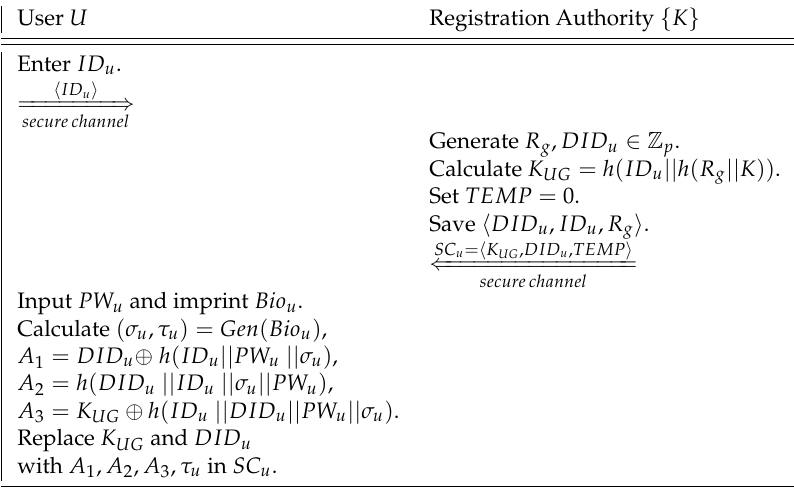
Figure 2. Summary of user